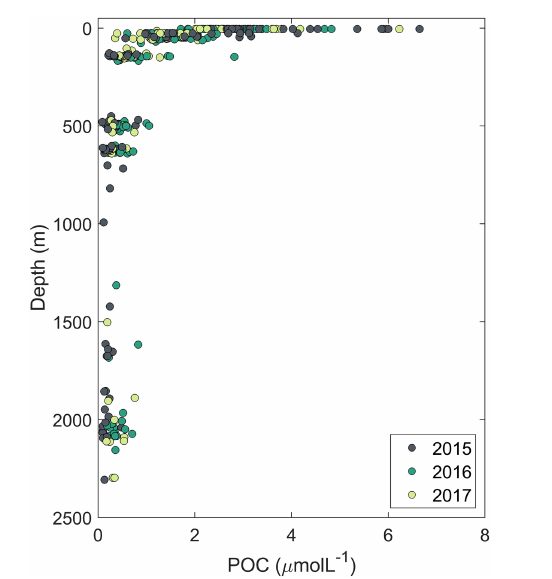
FIGURE 5 Surface and subsurface particulate organic carbon (POC) concentrations at different depths in the GoM for 2015, 2016, and 2017 cruises. POC concentrations at depths below the surface re fl ect the mean of the three discrete water sampling depths from which water samples were pooled.